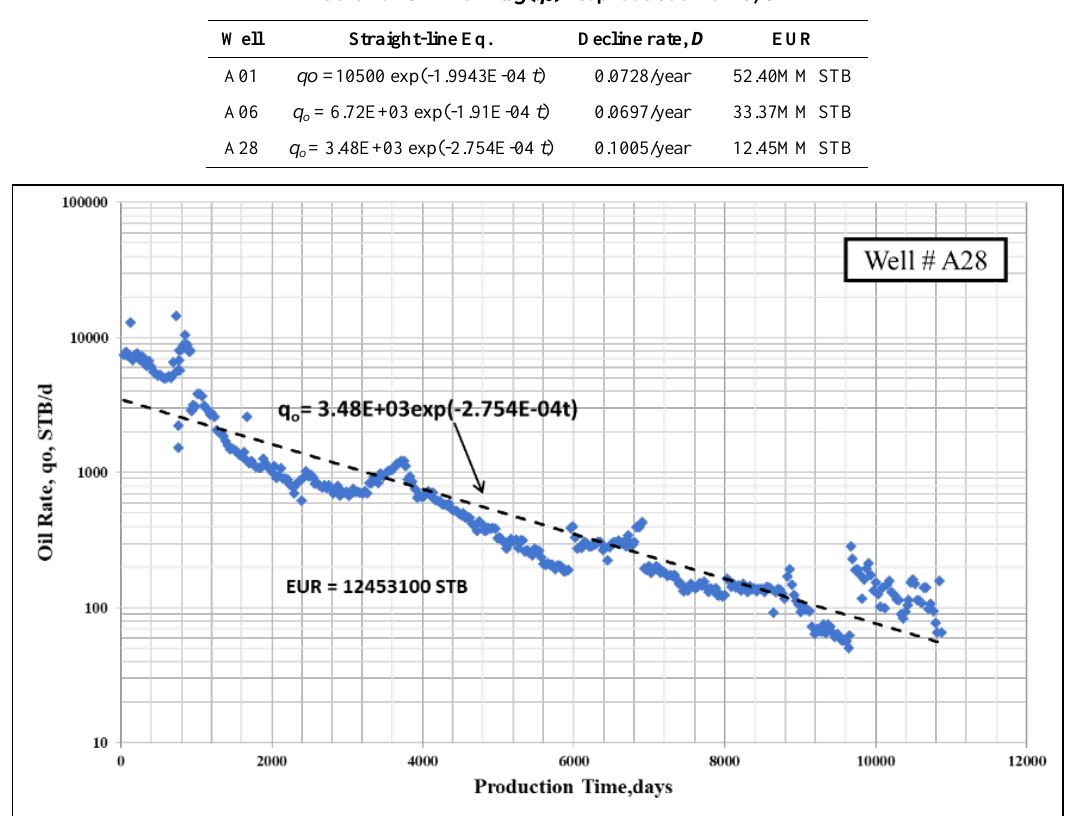
Table 1. EUR from log ( q o ) vs. production time, t